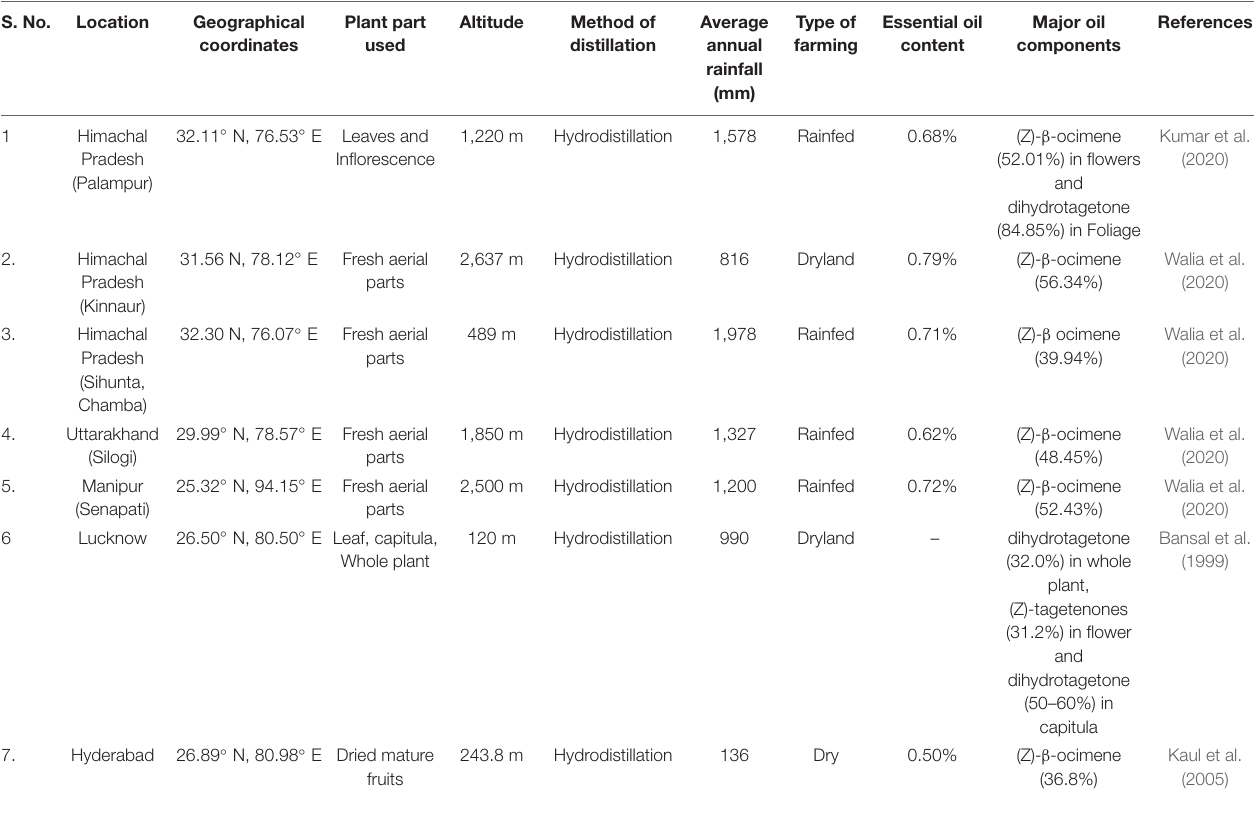
TABLE 3 | Essential oil composition as affected by different geographical locations and altitudes